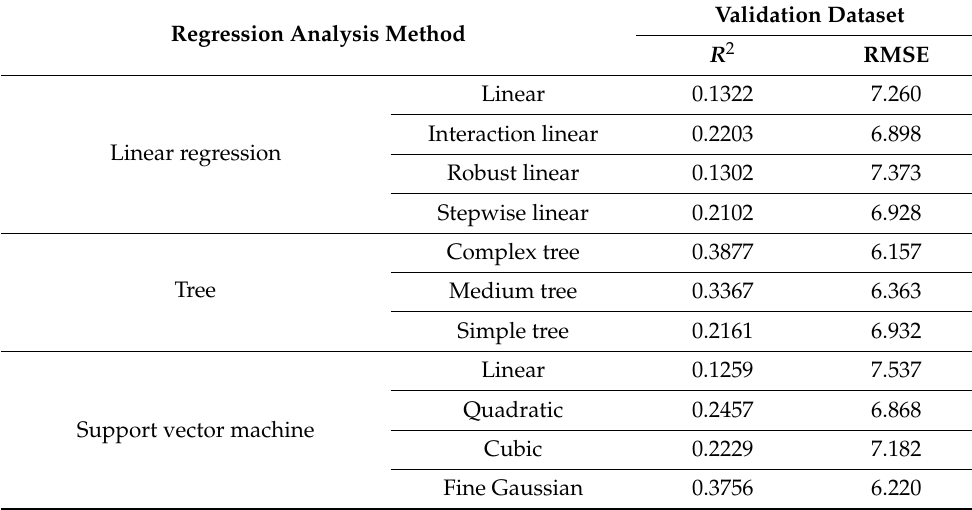
Table 7. Carbonation model prediction results of other regression